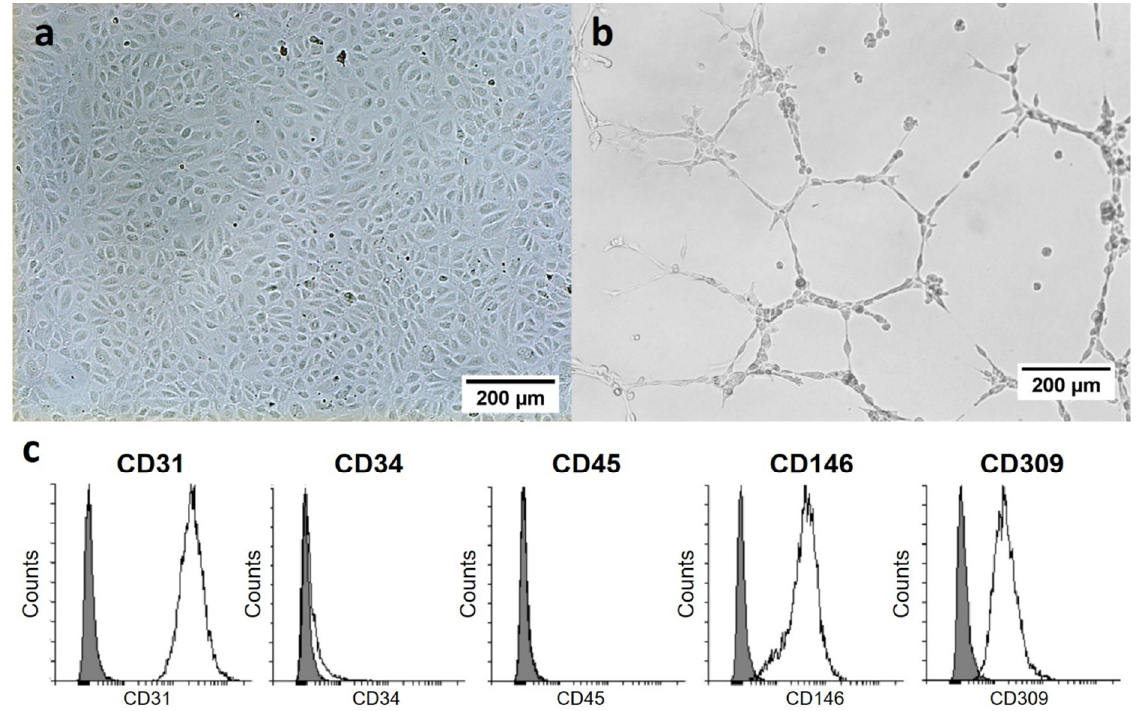
Figure 1. Human ECFCs isolated from peripheral blood. ( a ) Cobblestone-like single-cell layer of the ECFCs on a collagen-coated culture plate. ( b ) Growth of the ECFCs on a base membrane-like matrix leads to the formation of capillary-like structures. ( c ) Flow cytometric analysis of surface markers of ECFCs (white: ECFCs; grey: negative control).